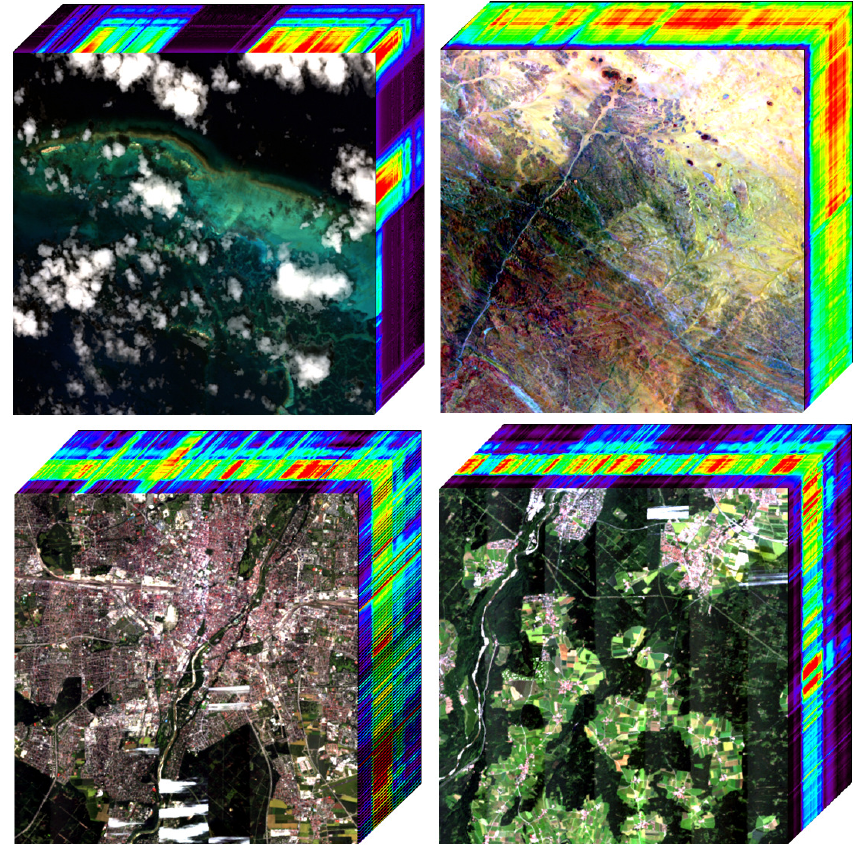
Figure 9. Scenes generated from simulated EnMAP scenes corresponding to different data applications. The hypercubes represent red-green-blue composites from a geological site in Namibia ( top left ), French Frigate Shoals in the Northwestern Hawaiian Islands ( top right ) and two acquisitions around the Munich area in Germany ( bottom